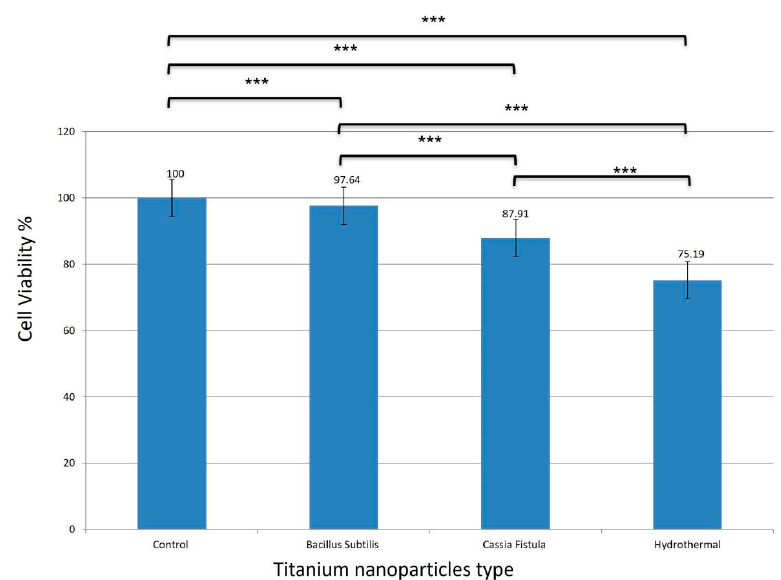
Molecules 2022 , 27 , x FOR PEER REVIEW Figure 10. Cell Viability (%) of titanium nanoparticles formed by Bacillus subtilis , Cassia fistula and titanium tetrachloride at first day in comparison to control group (*** p < 0.001, error bars = S.E).